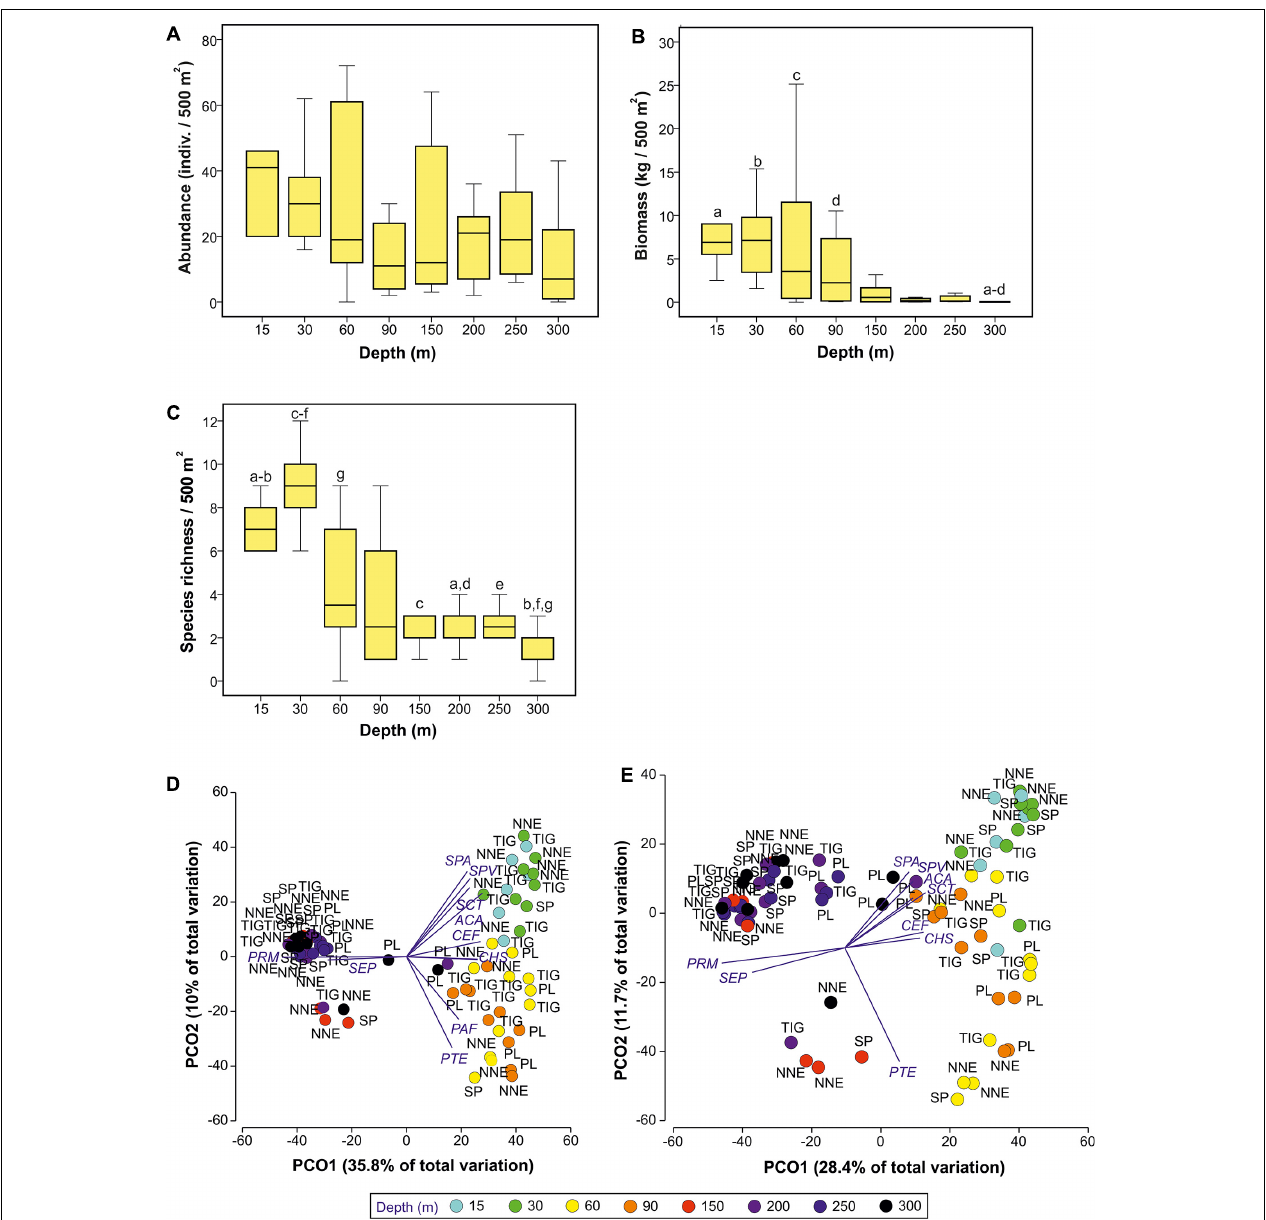
FIGURE 3 | Selected changes in fish assemblages with depth and location, as identified by Kruskal-Wallis (A–C) and Principal Component Analysis (D,E) . (A) Abundance against depth, (B) biomass against depth, (C) species richness against depth. Plots (A–C) indicate median and standards errors. Columns sharing the same letter indicate statistically significant differences ( p < 0.05) based on Mann-Whitney pairwise tests. Boxes indicate the 25th and 75th quantiles, whiskers are 1.5 the interquartile. (D,E) Principal coordinates analysis ordination on log(x + 1)-transformed fish abundance (D) and biomass (E) data at different depths using Bray-Curtis similarity resemblance matrix. Axes describe percentage variation in terms of total fish assemblage structure. Superimposed are vectors of species highly correlated with the two PCO axes (Pearson’s correlation coefficient, p ≥ |0.5|). The length and direction of the vectors represent the strength and direction of the relationship. NNE, North Northeast; PL, Plantagenet Bank; SP, Spittal; TIG, Tiger; ACA , Acanthurus chirurgus/bahianus ; CEF , Cephalopolis fulva ; CHS, Chaetodon sedentarius ; PAF , Paranthias furcifer ; PRM , Protonogrammus cf. martinicensis ; PTE, Pterois miles/volitans ; SCT , Scarus taeniopterus ; SEP , Serranus phoebe ; SPA , Sparisoma aurofrenatum ; SPV , Sparisoma viride